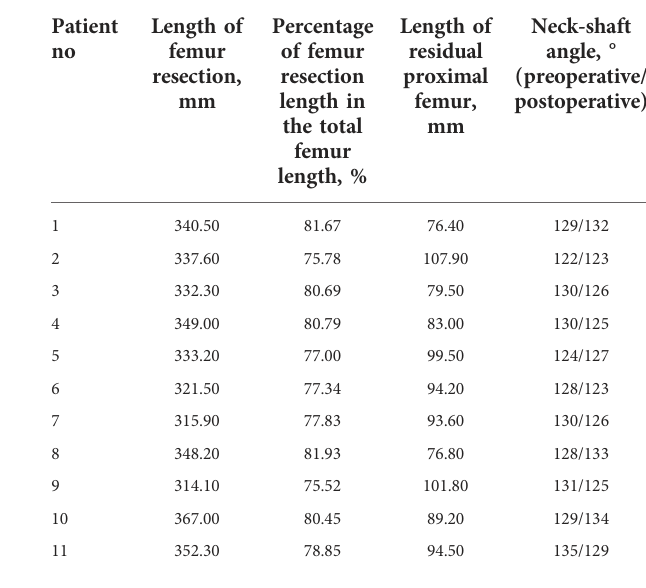
TABLE 2 Details of the surgical technique and neck-shaft angle